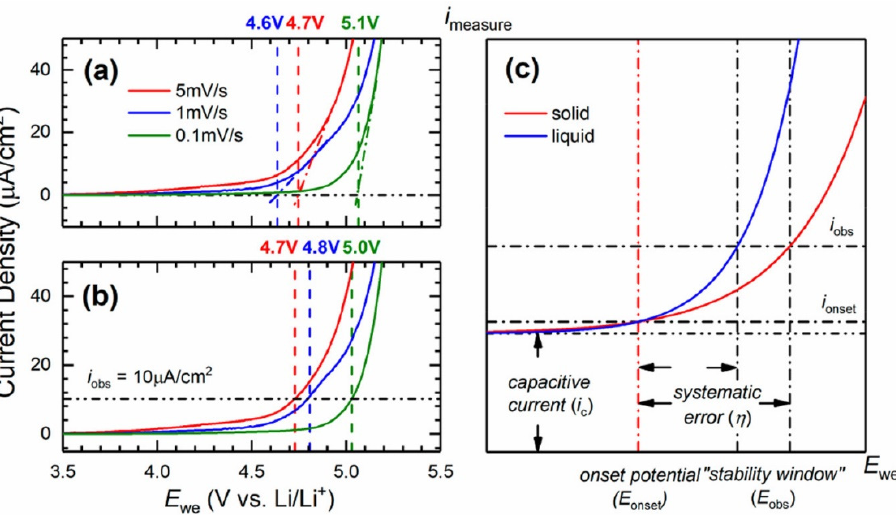
Figure 10. Linear sweep voltammogram of PEO:LiTFSI (O/Li = 10) from 3.5 to 5.5 V vs. Li + /Li at room temperature. Examples of “stability thresholds” determined by ( a ) extrapolating the voltam- mogram and ( b ) using an arbitrary onset current density. ( c ) Description of the systematic error in estimating the oxidative stability from current-based methods. Reprinted with permission from ref. [130]. Copyright 2021 American Chemical Society.